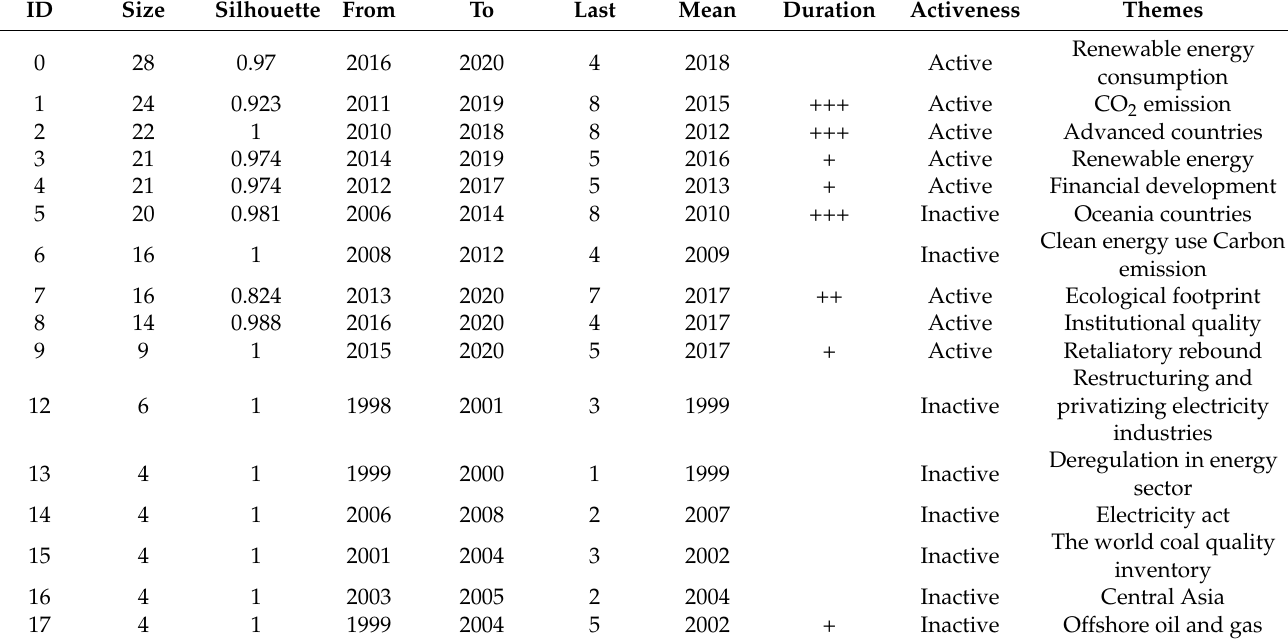
Table 4. Characteristics and information of the main